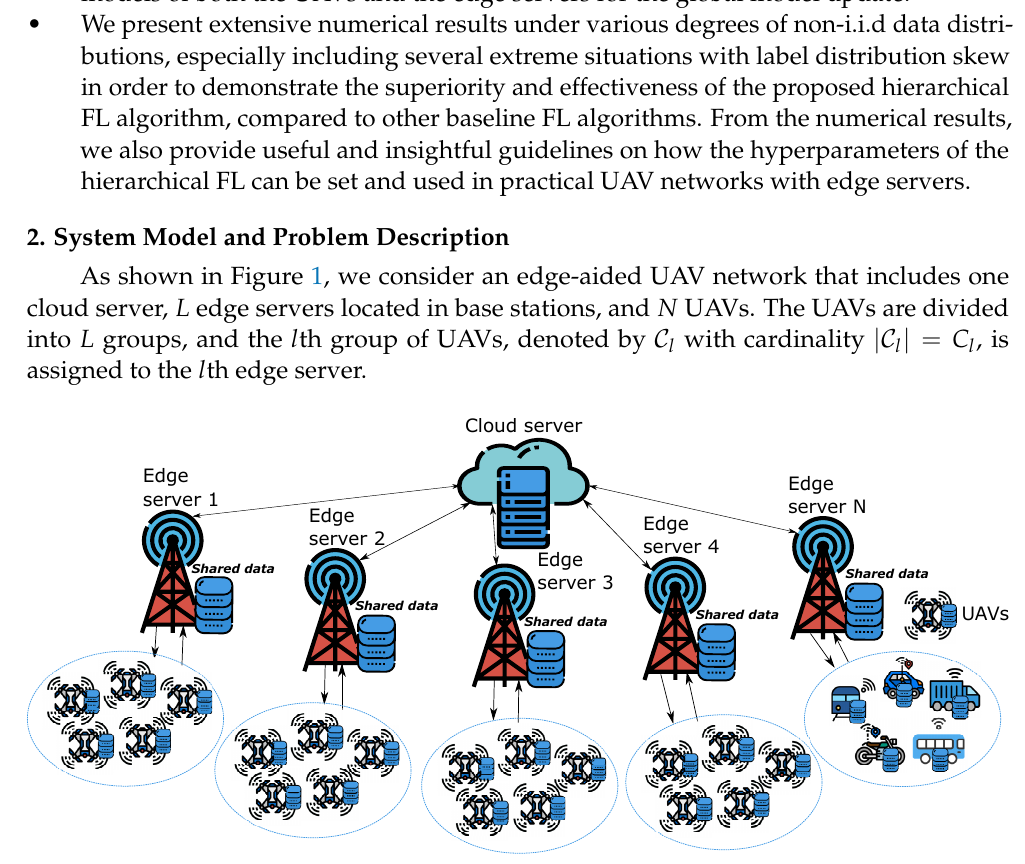
Figure 1. An edge-aided UAV